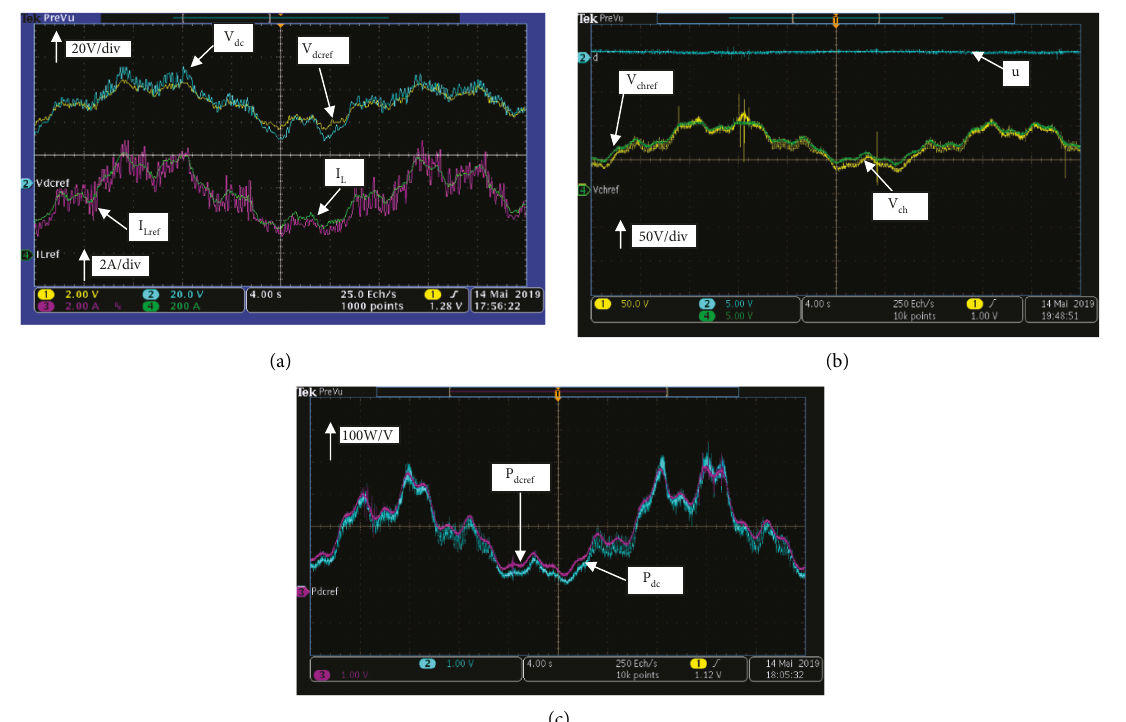
Figure 8: The response of (a) rectified voltage and inductance current, (b) load voltage and duty cycle, and (c) generator